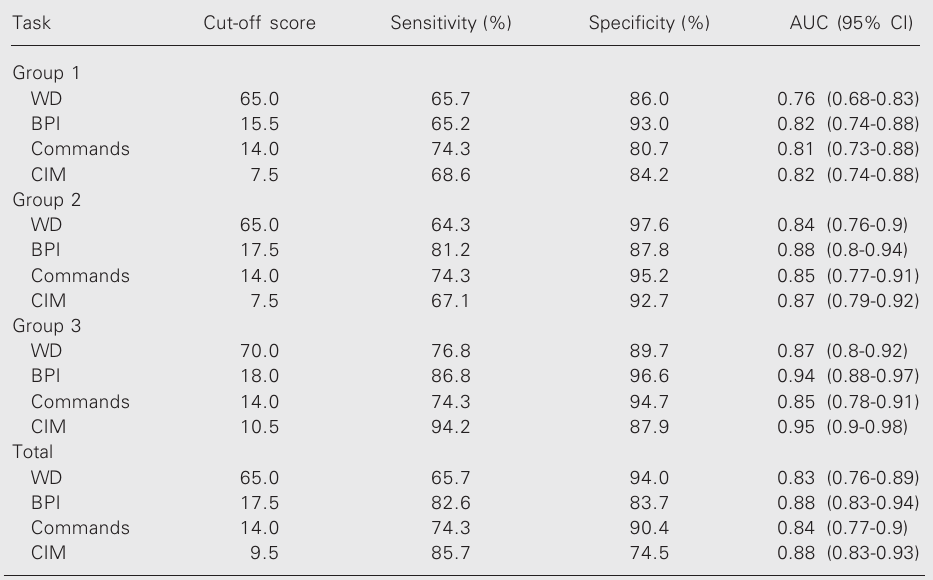
Table 7. Cut-off scores, sensitivity and specificity in the Auditory Comprehension tasks according to